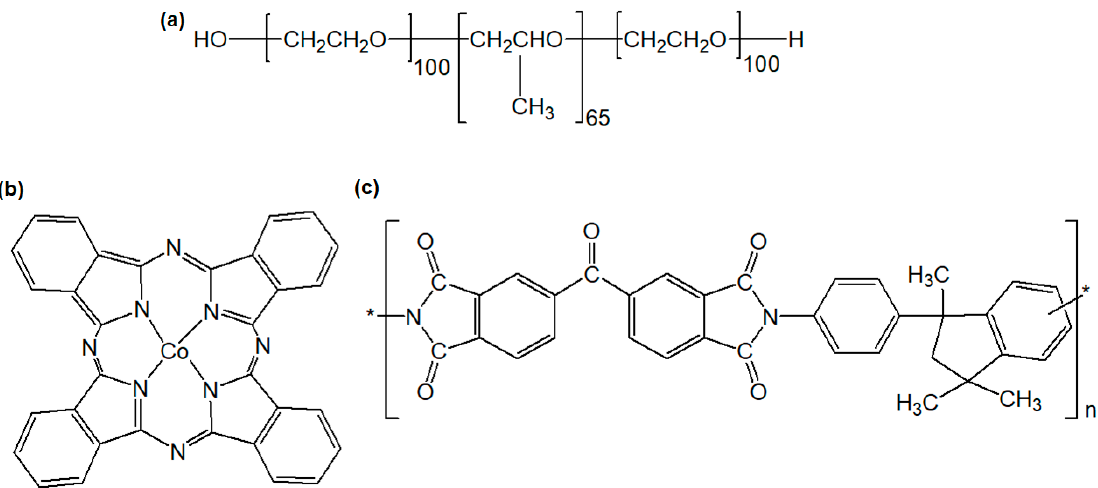
Figure 1. Chemical structures of ( a ) Pluronic ® , ( b ) cobalt(II) phthalocyanine microparticles (CoPCMPs), and ( c ) Matrimid ®